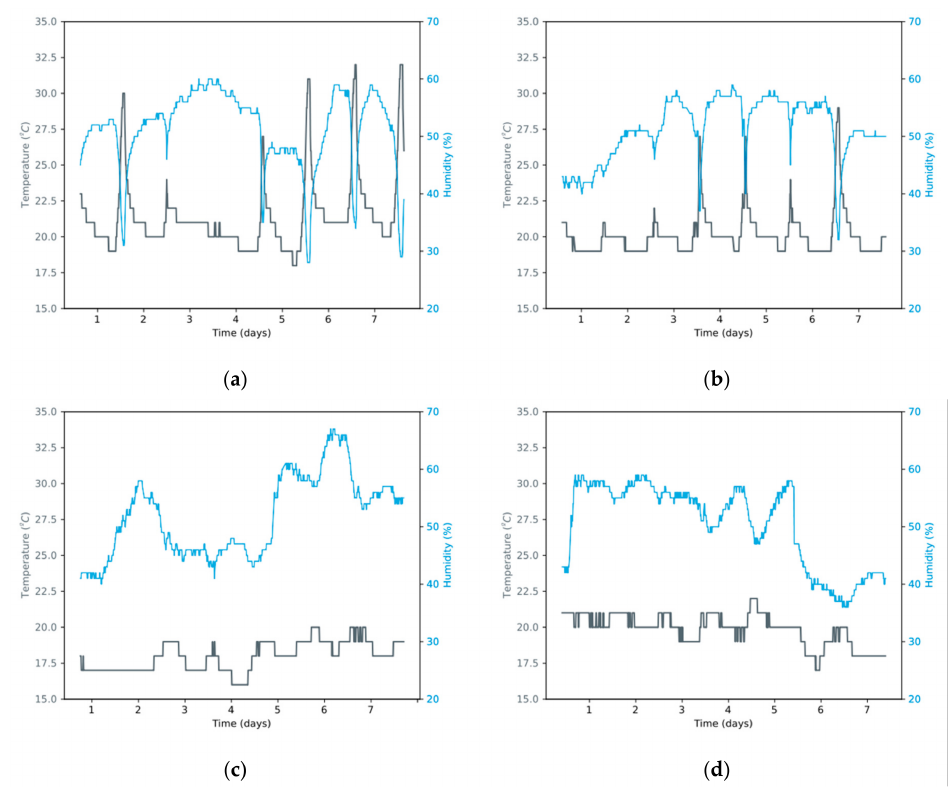
Figure 7. Evolution of temperature and humidity during a week for the tested interpolation time windows: ( a ) 10 min; ( b ) 30 min; ( c ) 1 h; ( d ) 2